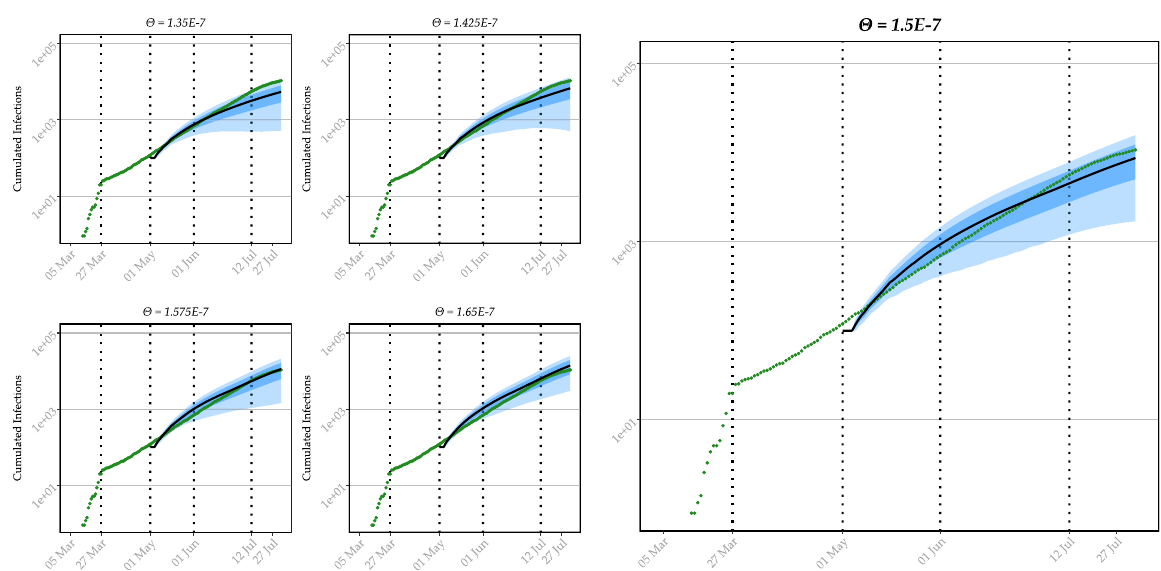
Fig. 6 Cumulative case numbers for NMBM (green dots) and simulated infection chains with daily averages (black lines) of 100 random realisations. Fifty and 80% con fi dence intervals for the estimations are depicted in blue. The dotted vertical lines refer to different periods of lockdown levels starting at 27 March 2020 with level 5. Lockdown level 4 was initiated on 01 May and eased to level 3 on 01 June 2020. The level 3 measures were altered during the subsequent weeks with major changes on 12 July 2020, when new school closures were announced. At the same time, several other stricter restrictions were already in power.